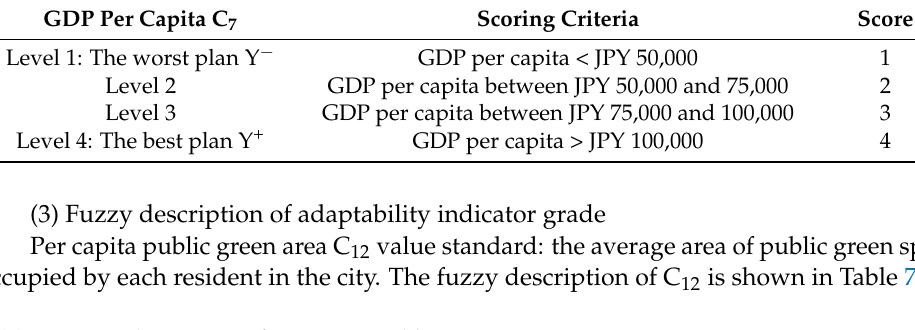
Table 7. Fuzzy description of per capita public green area.